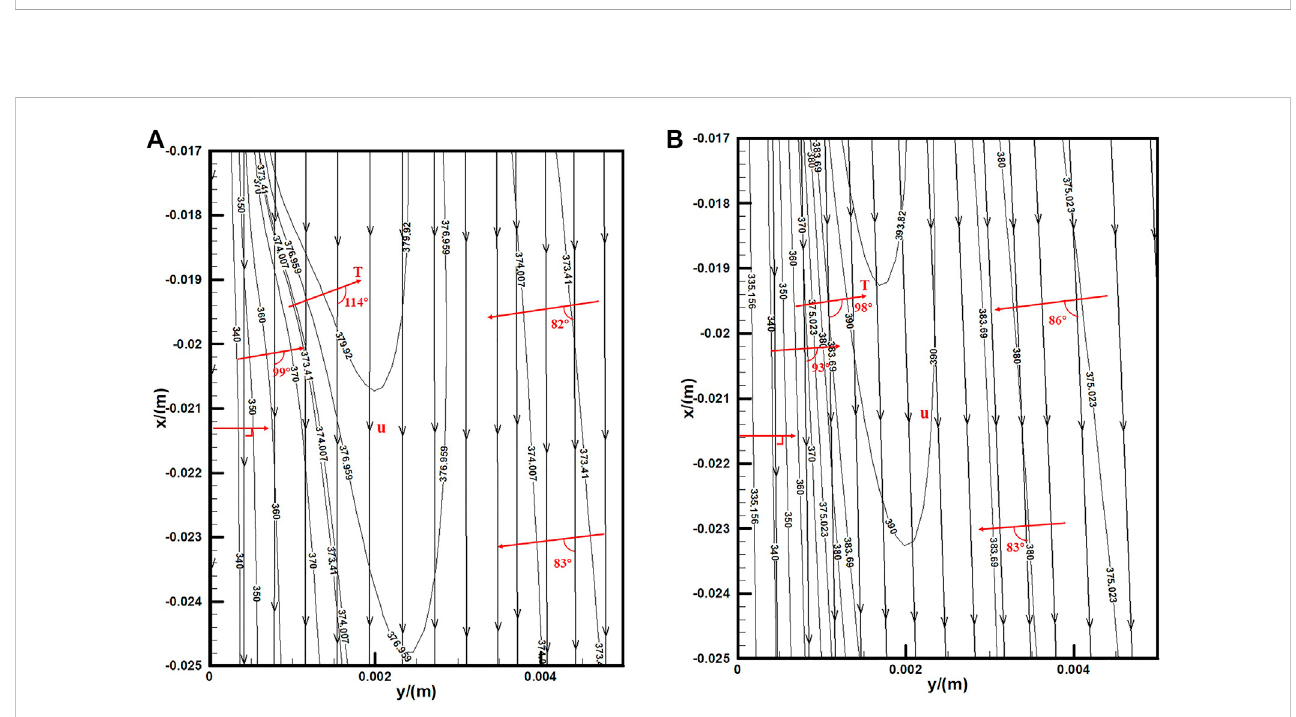
FIGURE 10 Temperature fi led and velocity fi led near the wall in Case 1: (A) t = 0.5 s; (B) t = 4.25